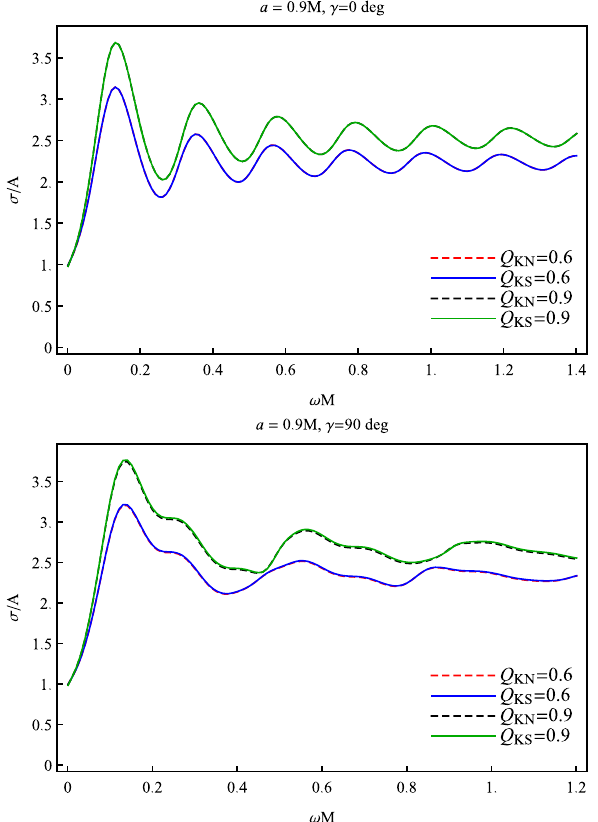
Fig. 7 Comparison between the ratio of absorption cross section and area of the black holes as a function of the normalised charge Q ( i ) = q ( i ) / q ext ( . The top panel corresponds to a wave with polar incidence i ) ( γ = 0 ◦ ) whereas the bottom panel corresponds to a wave with equa- torial incidence ( γ = 90 ◦ )